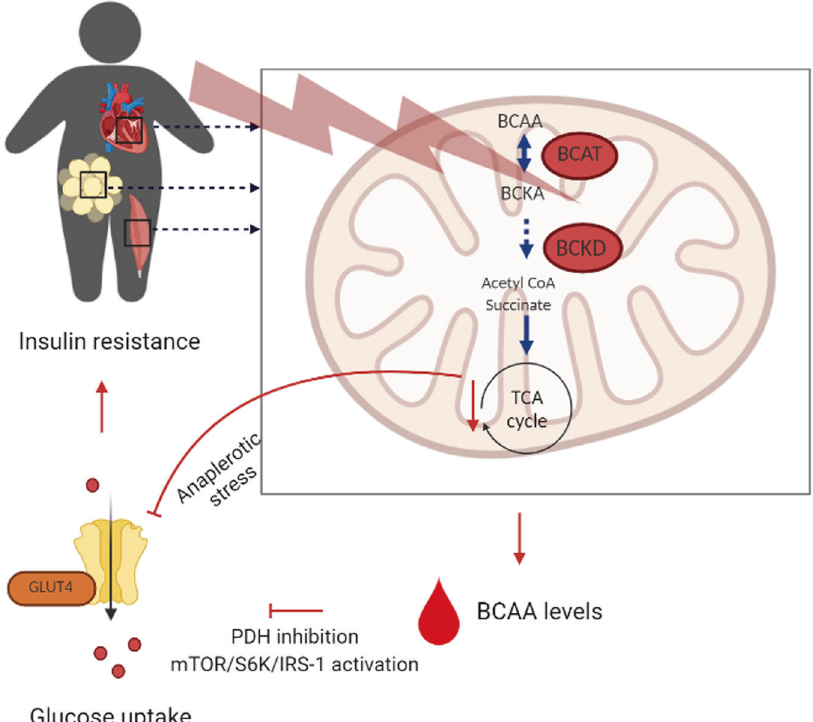
Fig. 2 Schematic overview of mechanisms linking BCAA catabolism with insulin resistance. BCAA branched-chain amino acids, mTOR mammalian target of rapamycin complex, S6K ribosomal S6 kinase, IRS-1 insulin receptor substrate-1, PDH pyruvate dehydrogenase complex, GLUT4 glucose transporter type